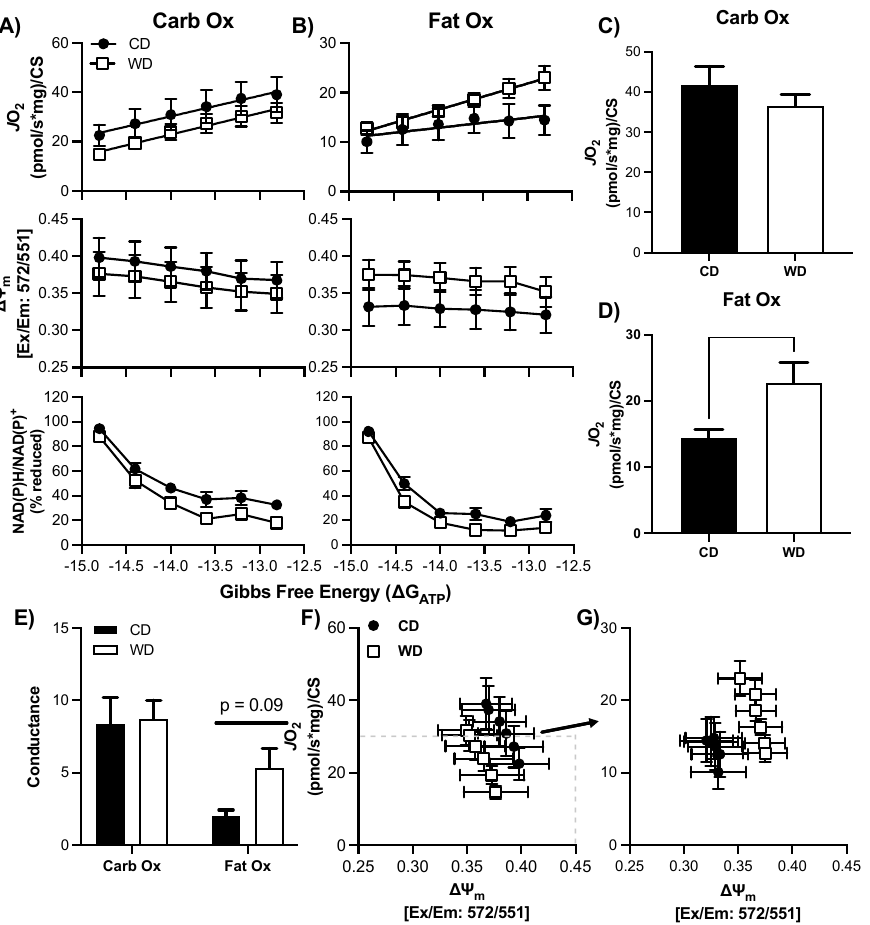
Figure 4. Respiratory control in male hypothalamic mitochondria following consumption of a West- ern (WD) or chow (CD) diet. A – B ) Changes in mitochondrial respiration ( J O 2 ), membrane potential ( ∆ψ ), and NADH reduction state (NAD(P)H/NAD(P)+) as a function of ATP free energy ( ∆ G ATP ) and substrate: carbohydrates ( A ) and fats ( B ). ( C , D ) Maximal mitochondrial respiration for carbohydrate substrates ( C ) and fat substrates ( D ). ( E ) Conductance slopes calculated from the linear phase of J O 2 as a function of ATP free energy ( ∆ G ATP ) for carbohydrate and fat substrates. F–G) Relationship be- tween mitochondrial J O 2 and ∆ψ in the presence of carbohydrate ( F ) or fat ( G ) substrates. Differ- ences were analyzed by two-way ANOVA for data shown in panels A and B with factors for diet (CD vs. WD) and ATP free energy. Main effects are noted in the absence of significant interactions ( p < 0.05). Differences were analyzed by Student’s t test for panels ( C – E ). 3.7. Consumption of a WD Alters Hypothalamic Mitochondrial Maximal Respiration in Females There was no statistical difference in basal respiration prior to the CK-clamp proce- dure between CD and WD for CarbOX ( p = 0.50, average 8.7 ± 4.9 pmol/sec/mg) or FatOx